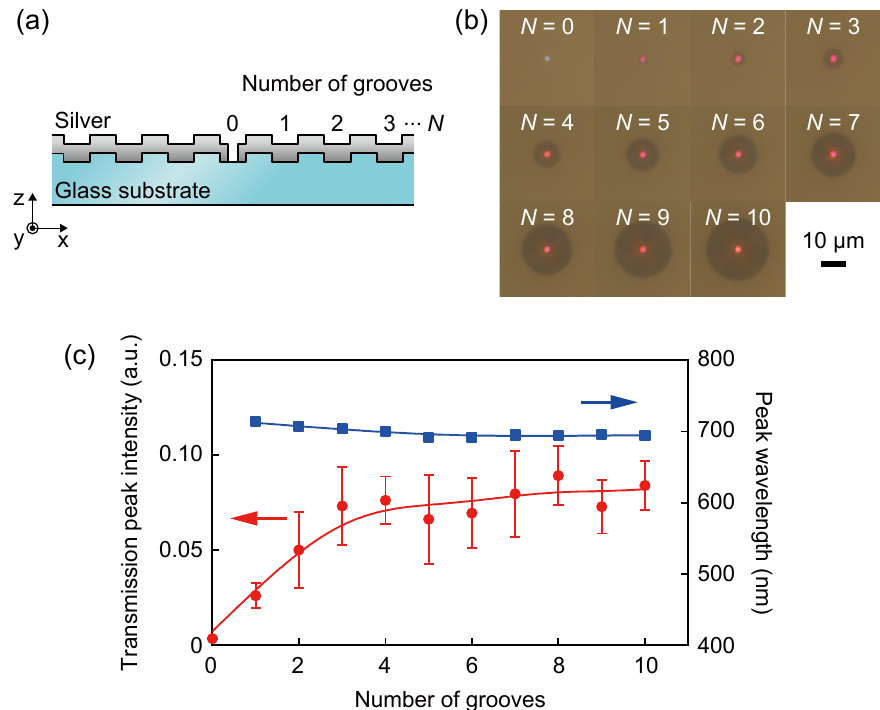
Figure 6. ( a ) A cross-sectional schematic of the corrugated plasmonic film. ( b ) Optical micrographs of the groove number dependence of transmitted power for N = 0 to 10. ( c ) The transmission peak intensity and peak wavelength dependence on groove number for N = 0 to